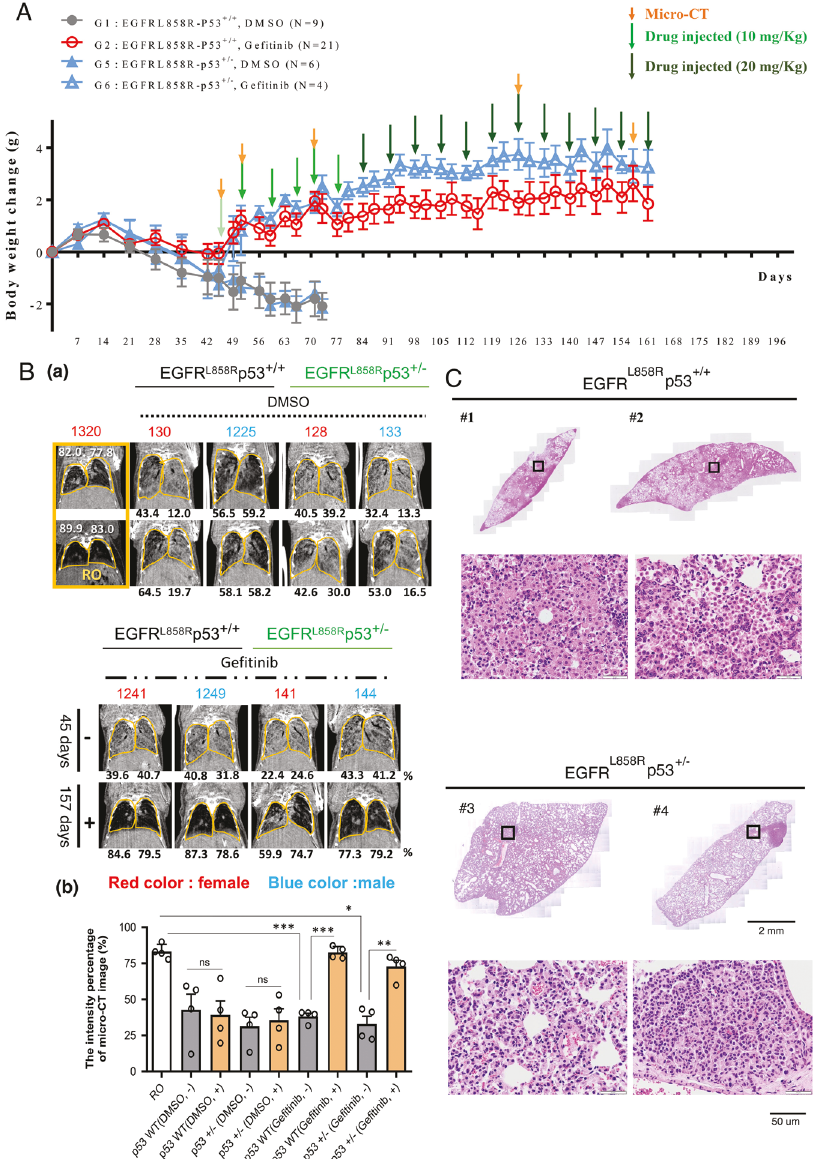
Fig. 5 Tp53 + / − promotes drug resistance in vivo. Lung tumors were induced in EGFR L858R *Tp53 + / + and EGFR L858R *Tp53 + / − mice including EGFR L858R *Tp53 + / + , DMSO ( n = 9), EGFR L858R *Tp53 + / + , Ge fi tinib ( n = 21), EGFR L858R *Tp53 + / − , DMSO ( n = 6) and EGFR L858R *Tp53 + / − , Ge fi tinib ( n = 4) by doxycycline (0.5 g/l in drinking water) treatment for 42 days, and the mice were then treated with 10 or 20 mg/kg ge fi tinib (green color arrow) until the establishment of drug resistance (161th day). The body weight of all the mice was measured every week ( A ), and the tumor growth was studied by micro-CT in the different stages (orange color arrow) ( B , a ) The signal (block color) of air space in the lungs was determined by Image J, and then the statistical analysis was performed by t test; * p <0.05, ** p <0.01, *** p <0.005, ns: non-signi fi cance ( B , b ). The pathology of mice with drug-resistant lung cancer mice with or without Tp53 + / − was studied by H&E staining ( C ). acquisition (Fig. 8). A total of 105 genes were upregulated, and (Fig. 7G). The data indicated that the CCNE1-high, CCNE1-high/ 55 genes were negatively regulated under the loss of p53 in drug- EGR1-low, CCNE1-high/SCGB3A1-low and OTX1-high/CCNE1-high resistant mice (Fig. 8A). Next, these genes were analyzed with a phenotypes, which might be involved in lung cancer malignancy, GO-dot plot (Fig. 8B) and a GO Upset plot (Fig. 8C). Several are related to poor prognosis in lung cancer. pathways, including the MyD88-dependent Toll-like receptor Tp53 + / − -mediated gene expression pro fi le in mice with drug- signaling pathway, lipogenesis-related gene expression reper- toires and regulation of circadian rhythm were differentially resistant lung cancer regulated in TP53 -mutated drug-resistant mice (Fig. 8B, C). Loss of Here, we have studied the global gene expression pro fi le in Tp53 - p53 increased the expression of most genes related to the MyD88- WT drug-resistant mice (Fig. 7). Because many cancer patients dependent Toll-like receptor signaling pathway, which is related have TP53 + / − , we also used drug-resistant mice with Tp53 to the NF- κ B pathway (Fig. 8B, C). In addition, most of the haploinsuf fi ciency ( EGFR L858R *Tp53 + / − ) to study the effect of p53 lipogenesis-related pathways, such as fatty acid metabolic process, mutation on global gene expression during drug resistance